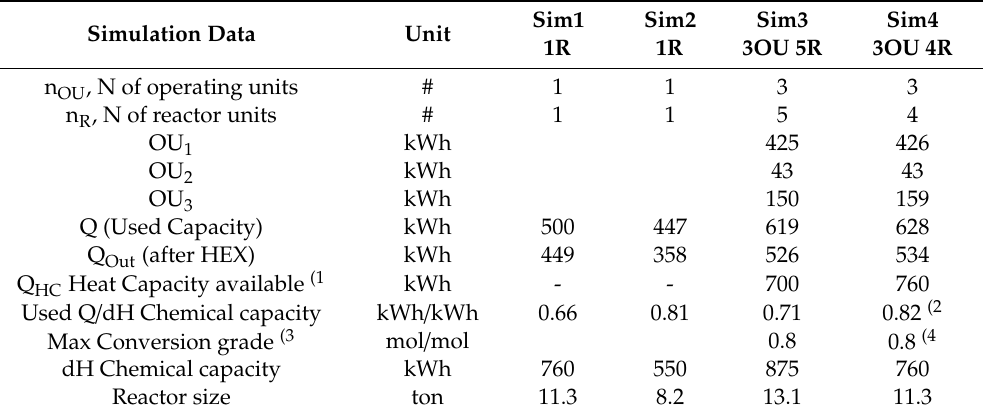
Table 3. Reactor set up and result from the